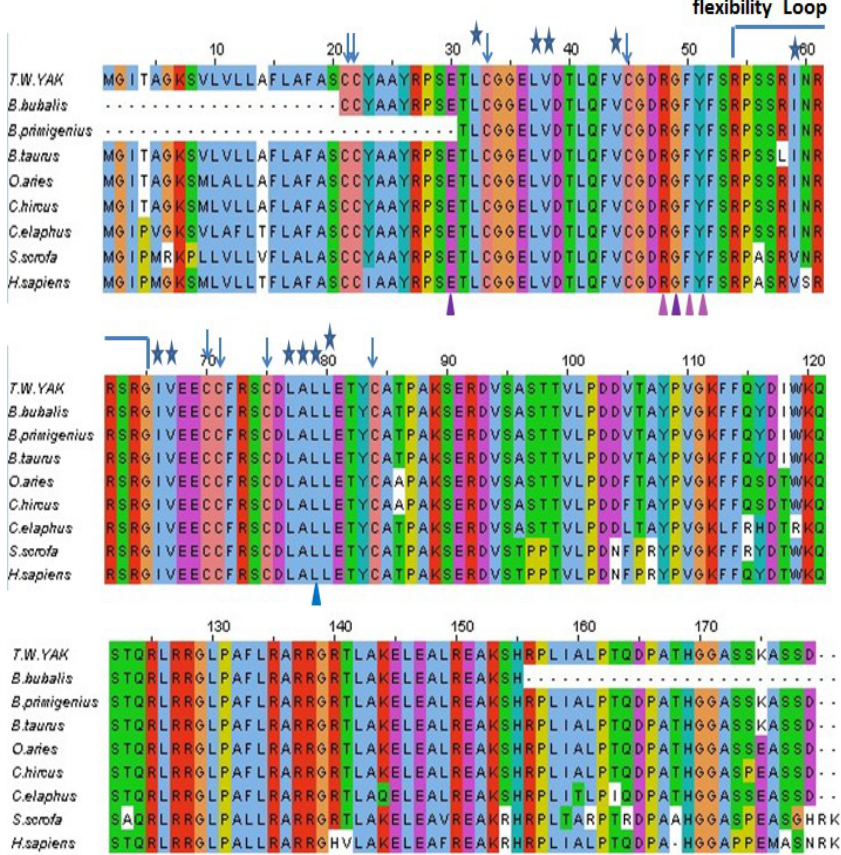
Figure 3. IGF2 amino acid sequence of the yak was compared with those from eight different mammalian proteins. The alignment was generated with the MAFFT (Multiple Alignment using Fast Fourier Transform) Multiple Sequence Alignment program. Residues were color coded according to their conservancy. The highly conserved IGFBP binding residues were labeled by (violet Δ), IGFBP and IGF-receptor and insulin-receptor binding residues were labeled by (lilac Δ) and IGF-receptor binding residues were labeled by (blue Δ). Conserved residues facilitate the binding of IGFBP, IGF- and insulin-receptor and IGF receptor. Conserved cysteines are shown as ↓. The hydrophobic residues forming the binding interface are shown as (blue ☆ ). There was a constant flexibility loop between the binding